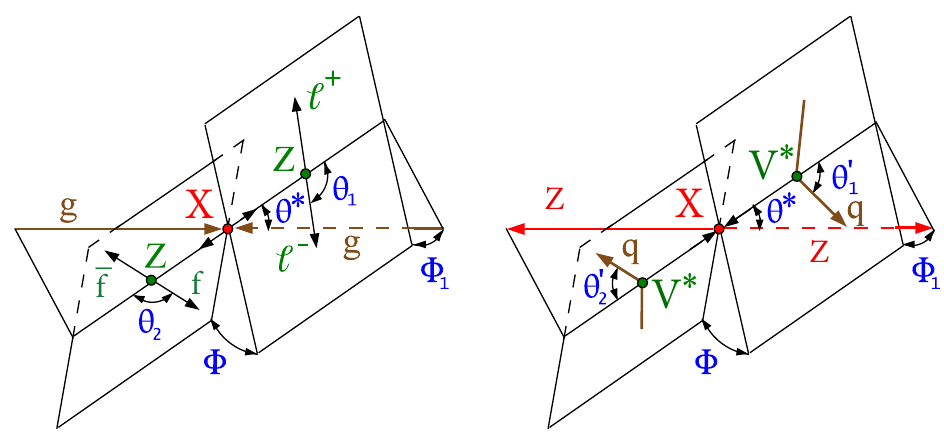
Figure 1 . Illustration of an X boson production from ggF, gg ! X ! ZZ ! ( ‘ + ‘ (cid:0) )( ff ) (left), and VBF, qq 0 ! qq 0 X ! qq 0 ZZ (right). The (cid:12)ve angles shown in blue and the invariant masses of the two vector bosons shown in green fully characterize either the production or the decay